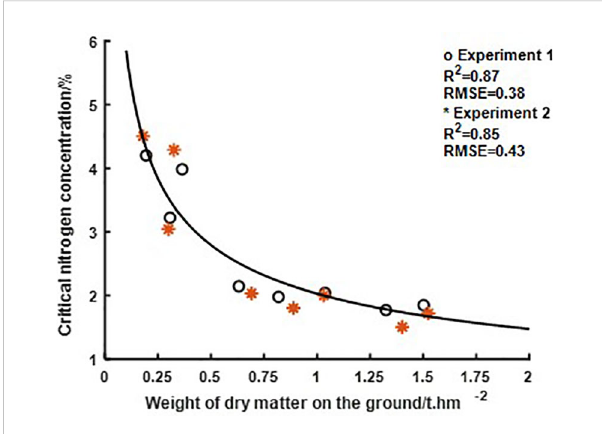
FIGURE 3 Fitting results of the critical nitrogen concentration curve. Eight points in the fi gure indicate the critical nitrogen concentration value corresponding to each sampling day in Experiment 1, and eight asterisks indicate the critical nitrogen concentration value corresponding to each sampling day in Experiment